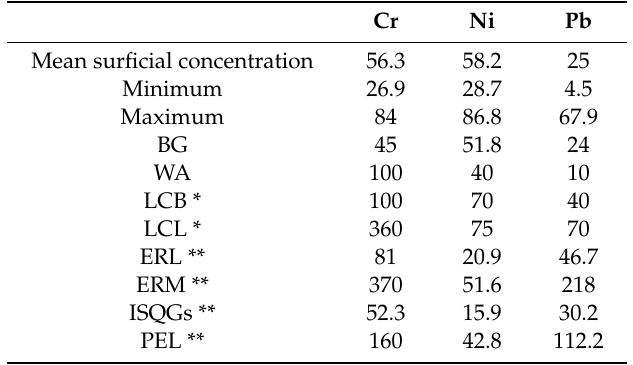
Table 2. Minimum, maximum and average concentrations (in µ g / g d.w.) of heavy metals in box-core sediments. Comparison with Italian and international sediment quality guidelines